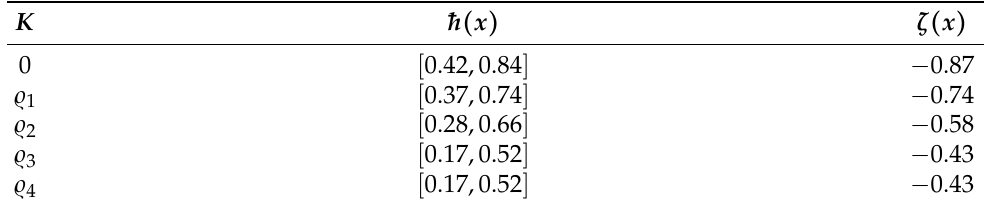
Table 4. Tabular representation for